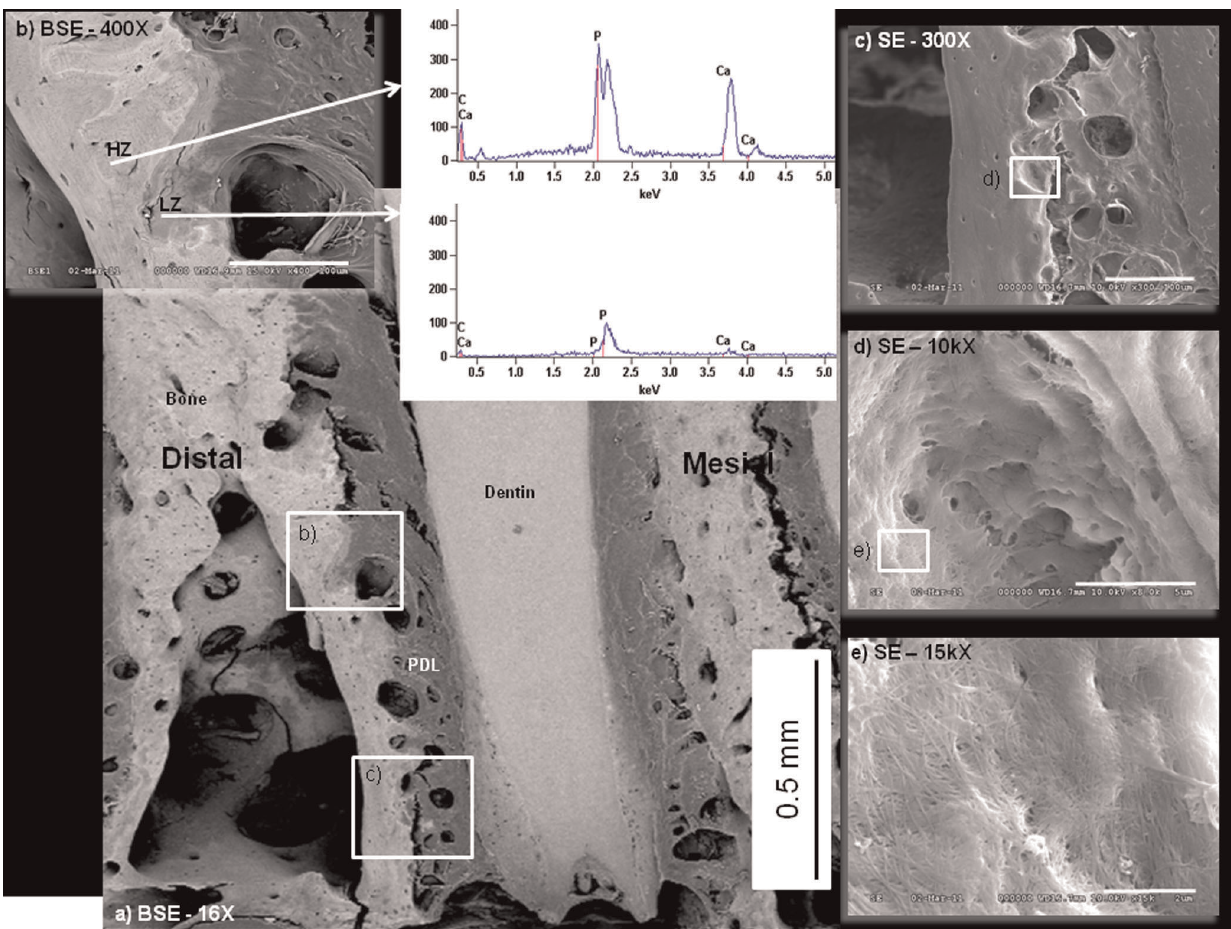
Figure 6. Elemental mapping using BSE and EDS. a) SEM in BSE mode indicated distribution of high and low Z elements of the periodontium. Scale Bar=0.5 mm. b) Using SEM-BSE greatest heterogeneity is observed in the different layers of bone owing to different chemical compositions of bone during its turnover (i.e. remodeling or modeling). Scale Bar=100 m m. Representative point shoot EDS demonstrate varying counts of Ca and P (K a 1, K a 2, and K b 1 lines) within adjacent regions. SE mode indicates at length scales c) the enthesis region of PDL-bone with scale bar=100 m m, d) the site of a resorption pit, which indicate the digested layers of bone with scale bar=5 m m, and e) the exposed collagen fibers that help compose a mineralized matrix with scale bar=4 m m.